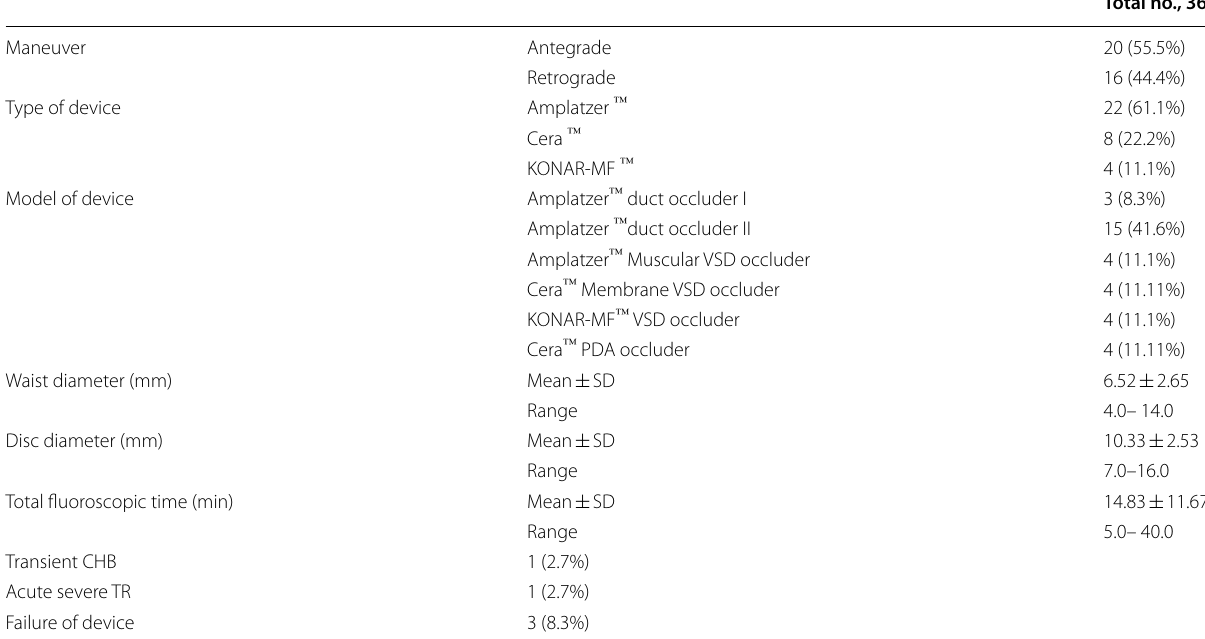
Table 2 Procedure data in group